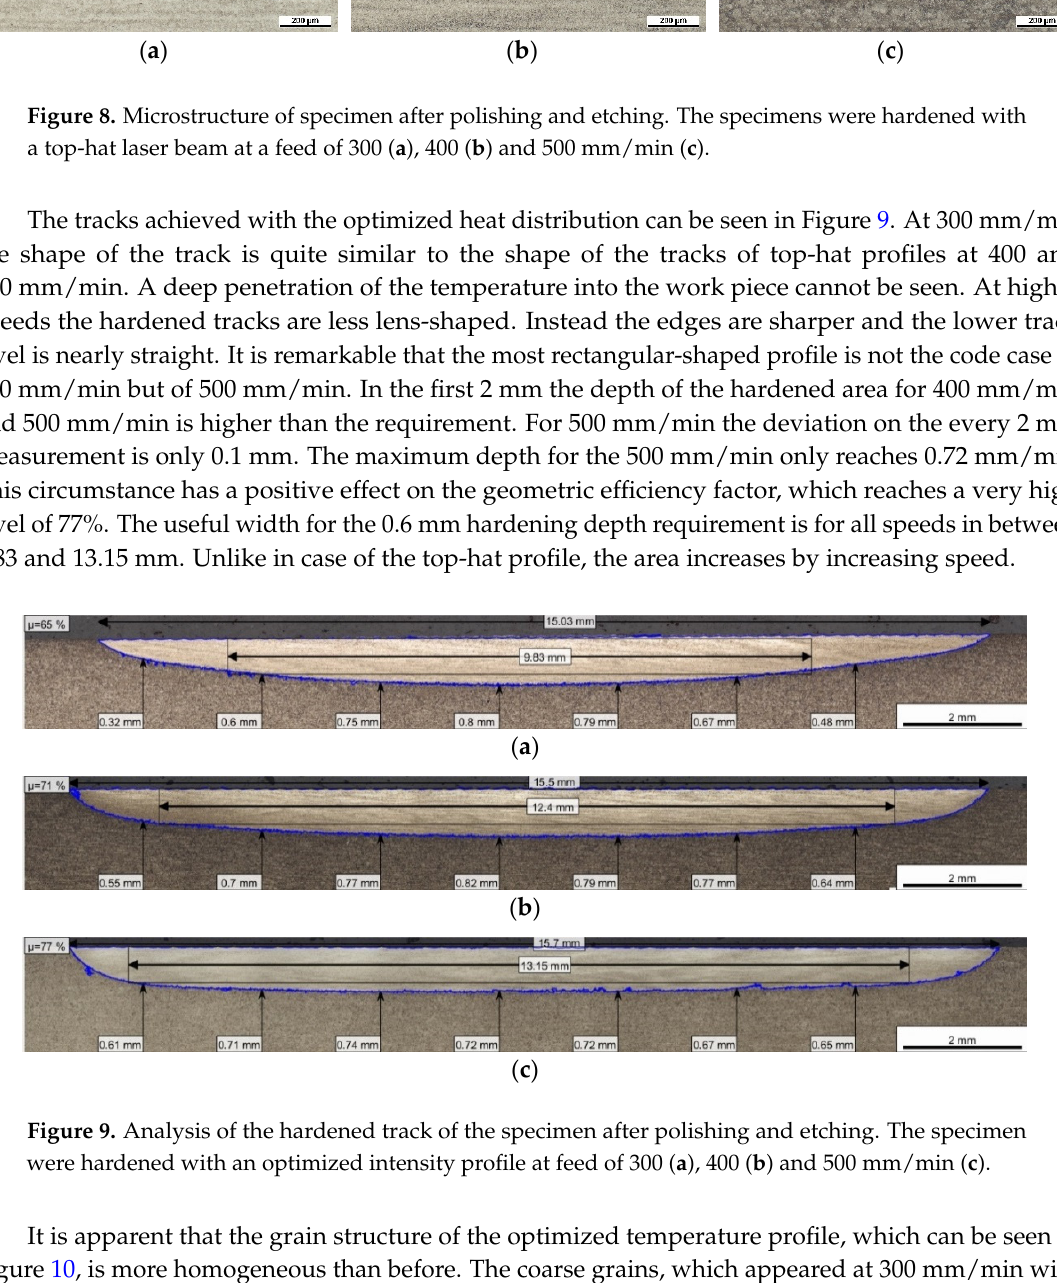
existent. In Figure 10 it can also be seen that the hardening depth is not dependent on the feed of the laser. All pictures show nearly the same hardening depth. In the transition zone, a thin layer can